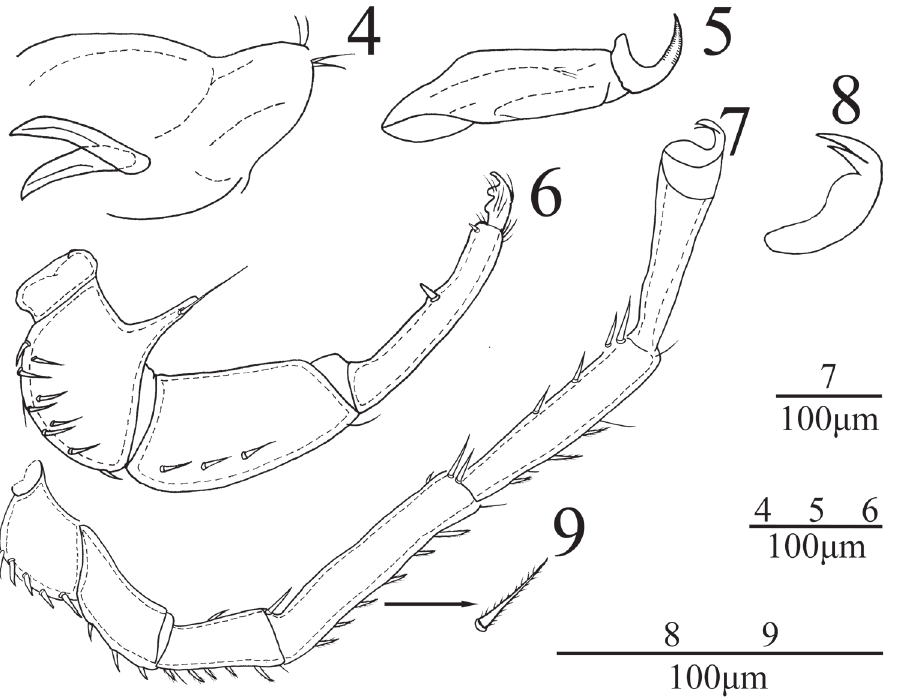
Figures 4–9. Sperchon fuxiensis sp. n., Female 4 infracapitulum 5 chelicera 6 palp 7 IV-L-1–IV-L-6 8 claw 9 dorsal seta of